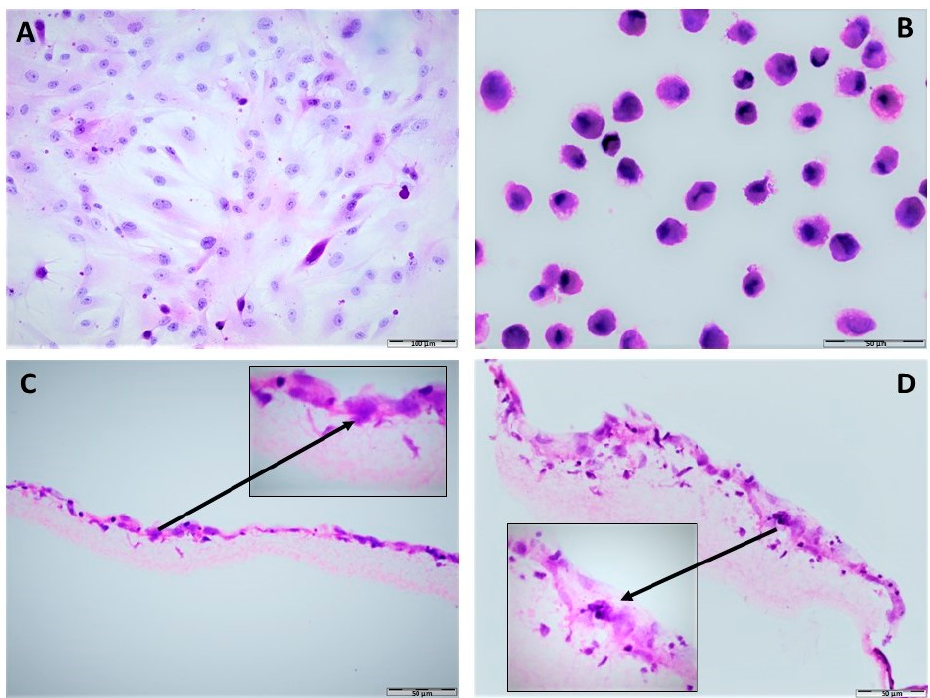
Figure 2. Histological analysis of the hDPSCs-PLCL construct after seven days of culture. ( A ) ad- herent hDPSCs morphology grown as a monolayer, spindle shape of cells is visible ( B ) cytospin specimen, morphological features of hDPSCs ( C ) hDPSCs covering the PLCL surface and individual cell infiltrating the PLCL nanofibers ( D ) a large number of hDPSCs infiltrate the deeper layers of the scaffold. Arrows indicate cells. Hematoxylin-eosin staining. Scale bar = 100 μ m ( A ) and 50 μ m ( B – D ).